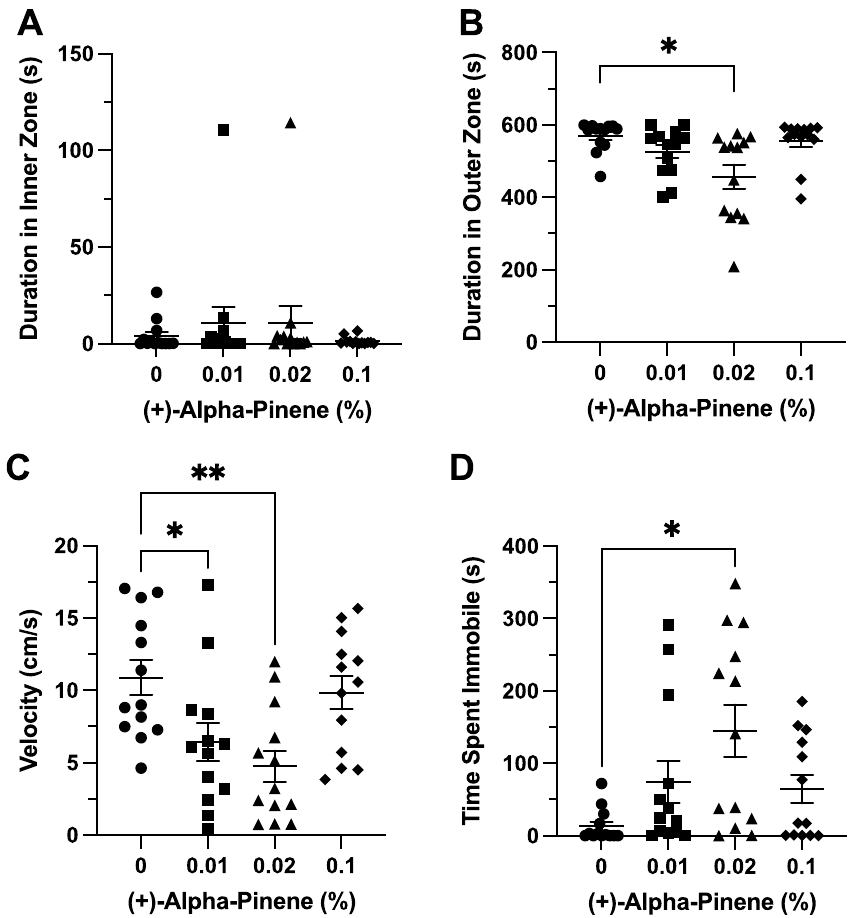
Figure 7. The effects of (+)-alpha-pinene administration in the novel object approach test. Average duration of time fish spent in the ( A ) inner and ( B ) outer ‘thigmotaxis’ zone during the novel object approach test. Fish locomotion was quantified in the novel object approach test by measuring ( C ) swimming velocity and ( D ) time spent immobile. All data are presented as mean ± S.E.M. Significant differences between controls and (+)-alpha- pinene treated groups are indicated by *( p < 0.05) and **( p <